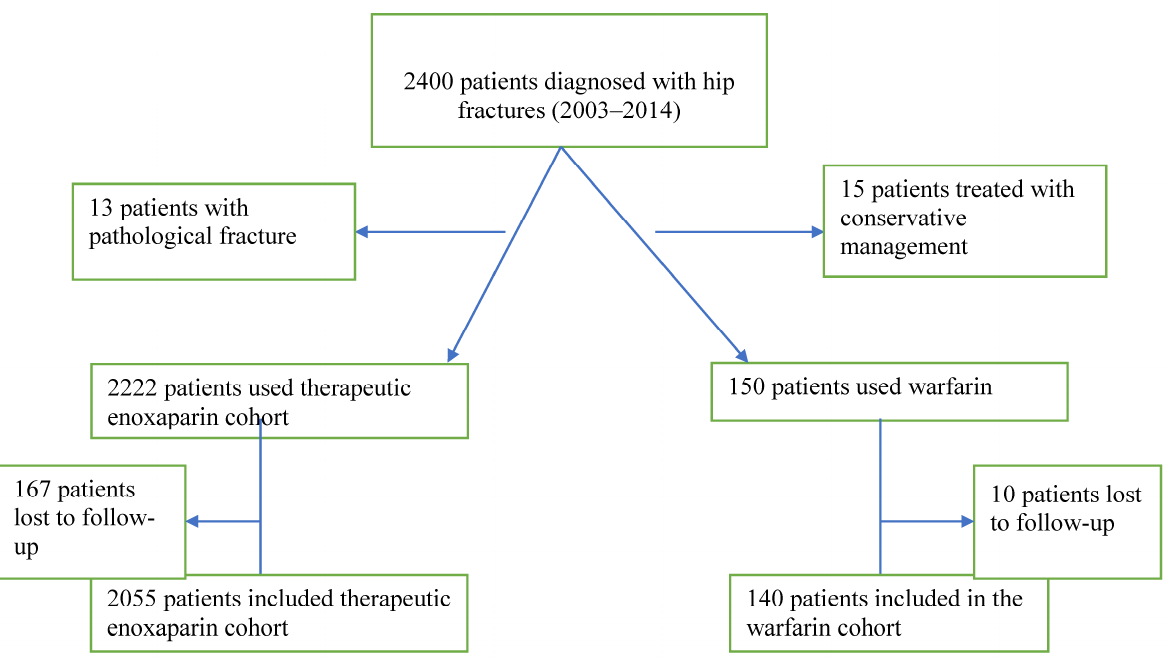
Figure 1. Inclusion criteria for patient selection.